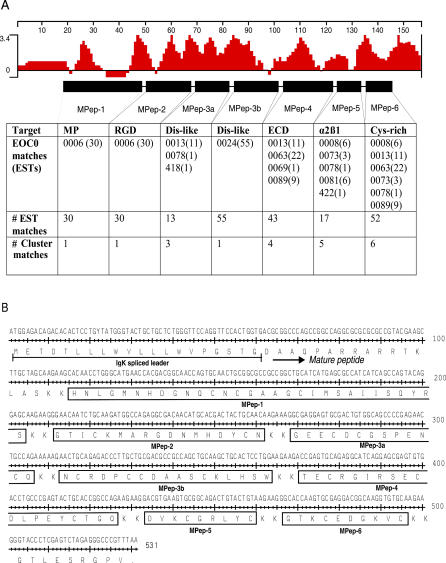
The EoSVMP String(A) Upper graphic: Jameson-Wolf antigenic profiling of the mature EoSVMP string synthetic DNA immunization construct. Lower chart: Target domains for individual MP epitopes. Cluster matches against each peptide are shown. The number of ESTs in each cluster is indicated in parentheses. α2β1, α
2β
1 integrin-binding motif in Jararhagin-C; Cys-rich, C-terminal region of the cysteine-rich domain; Dis-like, disintegrin-like domain; ECD, ECD motif and flanks; MP, metalloproteinase catalytic domain; RGD, RGD-containing PII and flanking sequences.
(B) Complete nucleotide and coding sequence of EoSVMP string. Sequence and locations of epitopes, separated by lysine spacers are indicated.